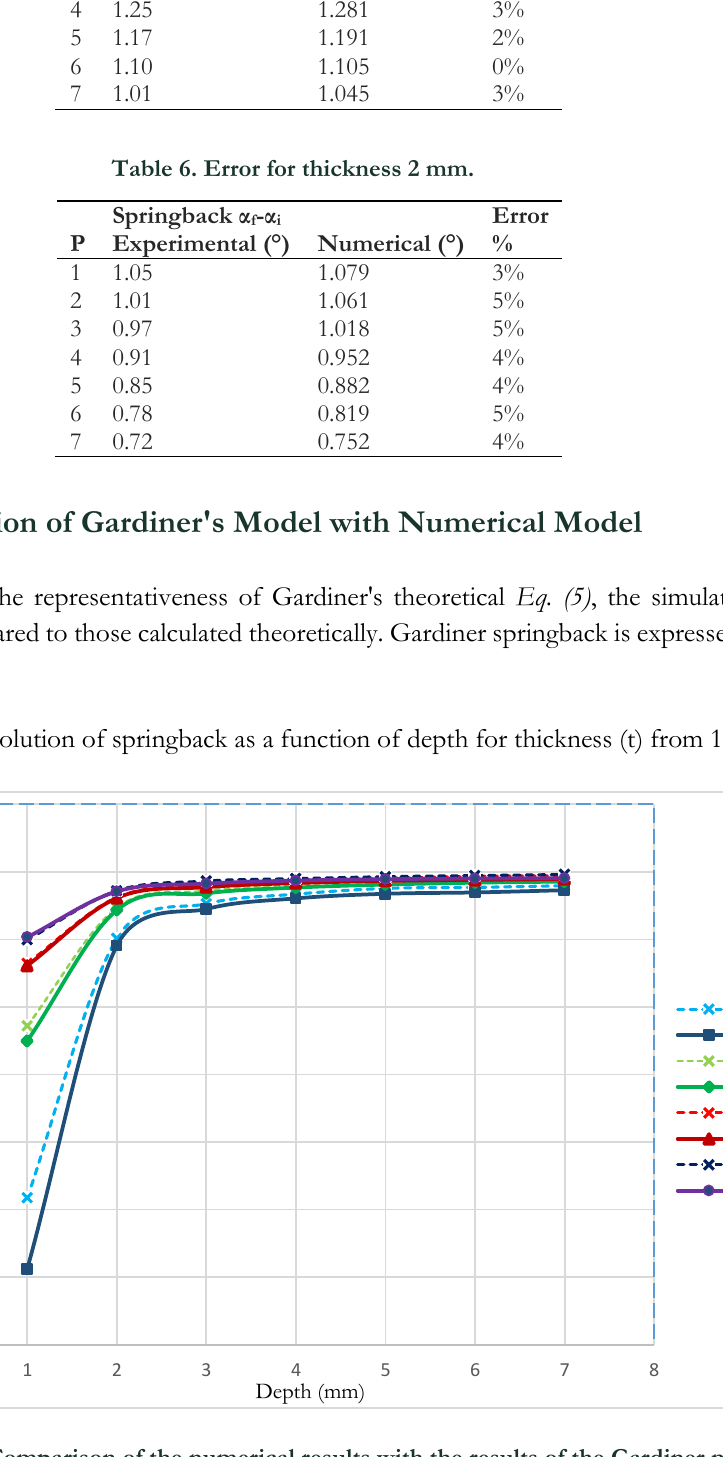
Fig. 13. Comparison of the numerical results with the results of the Gardiner